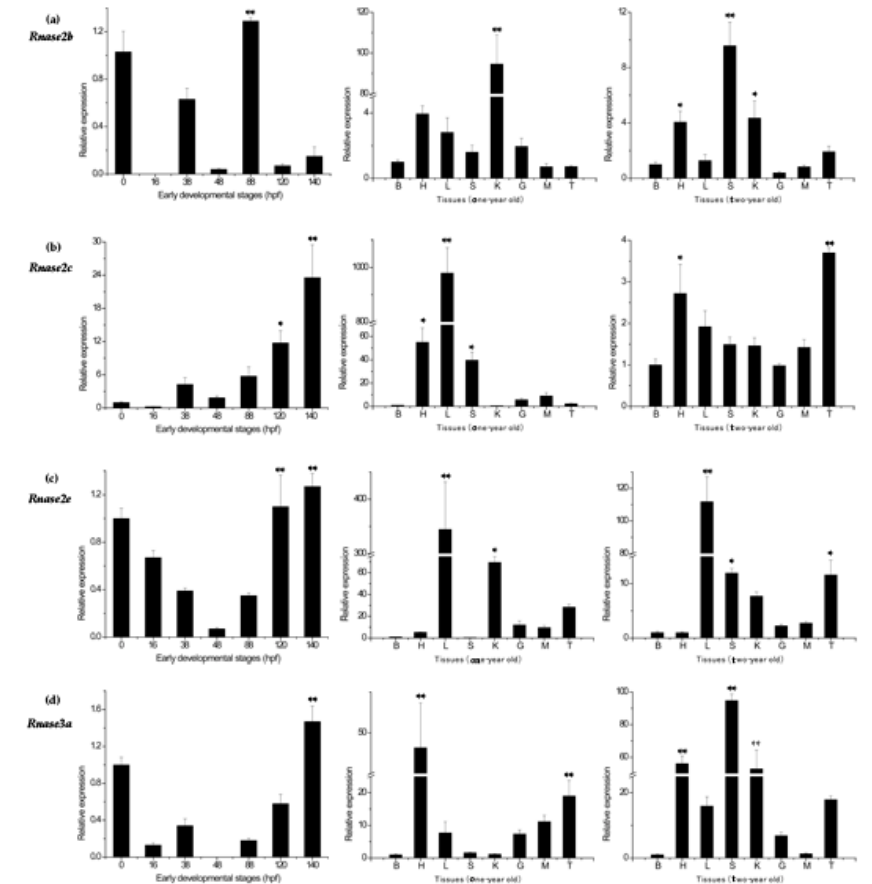
Figure 4. Expression patterns of ( a ) Rnase2b , ( b ) Rnase2c , ( c ) Rnase2e and ( d ) Rnase3a genes in different developmental stages and tissues of M. amblycephala . β -actin was used as the reference gene. Tissues: brain (B), heart (H), liver (L), spleen (S), kidney (K), gut (G), muscle (M), and testis (T). Developmental stages: 0 h post-fertilization (hpf) (fertilized egg), 16 hpf (late gastrulastage), 38 hpf (heart appearance), 48 hpf (hatching), 88 hpf (eye appearance), 120 hpf (air bladder formation) and 140 hpf (intestine appearance). The expressions in different developmental stages were normalized to the fertilized egg stage, while expressions in tissues were normalized to the expressions in brain tissue (both set as 1, or control group). Differences were statistically analyzed using one-way analysis of variance (one-way analysis of variance (ANOVA)). Highly significant differences from the control group ( p < 0.01) are marked with **, and significant differences ( p < 0.05) with *. 3.5. Expression Profiles of Rnase2 and Rnase3 Messenger RNA after Aeromonas hydrophila Challenge After an A. hydrophila immune-challenge, time-dependent relative (to the control group) expression patterns of Rnase2 and Rnase3 mRNA were observed in all five studied tissues (liver, spleen, kidney, gut and blood). The expression of Rnase2b showed down-regulated at 6 hpi (in comparison to the control) in liver (0.02×), spleen (0.24×), kidney (0.42×), gut (0.04×) and blood (0.02×) samples, and down-regulated at 12 hpi in liver (0.21×), spleen (0.48×), kidney (0.75×), gut (0.03×) and blood (0.14×) samples (Figure 5 (a)), while the differences were not significant ( p > 0.05). The expression of Rnase2c was only significantly ( p < 0.01) up-regulated (1.83×) in spleen at 6 hpi compared to control, while down-regulated at 12hpi compared to 6hpi ( p < 0.01). No significant differences ( p > 0.05) were found in other tissues (Figure 5 (b)). The expression of Rnase2e was significantly ( p < 0.01) increased in kidney at 6hpi (42.27×) and 12 hpi (3.12×), followed by liver at 6hpi (2.44×) ( p < 0.05), while no differences were found in spleen, gut and blood ( p > 0.05) (Figure 5 (c)).